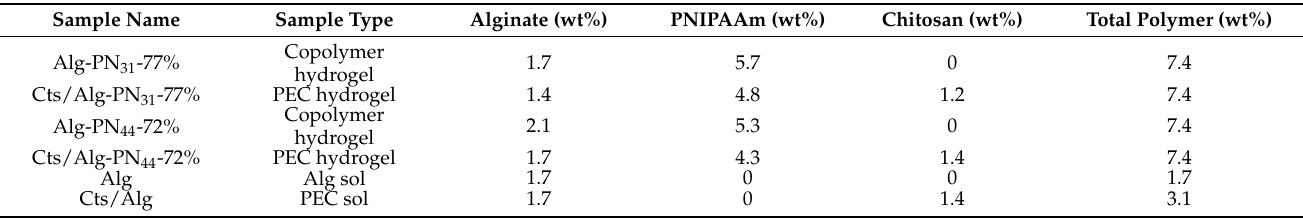
Table 2. Formulations of polymer samples use for PEC hydrogel